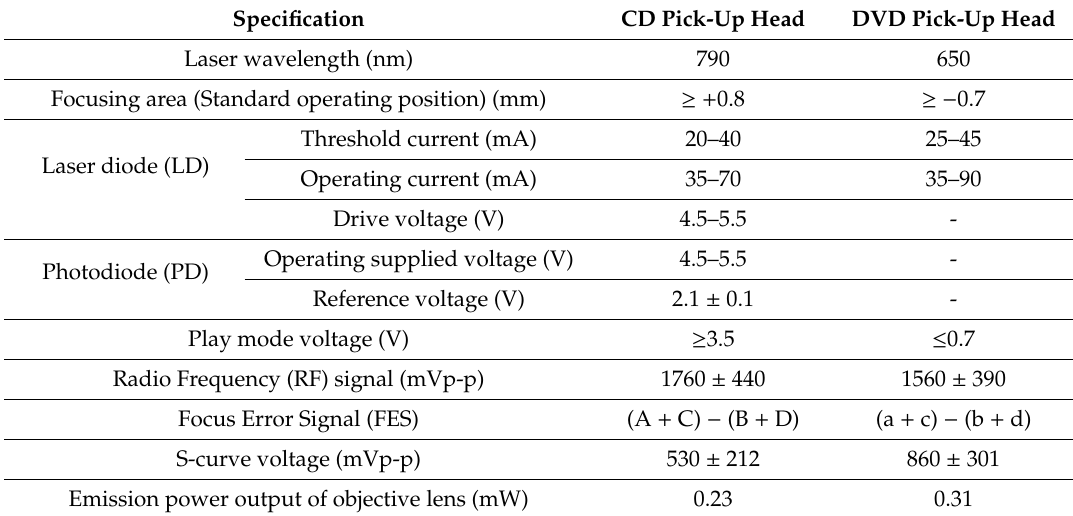
Figure 3. Circuit diagram of the developed photodiode detector and signal amplifier.